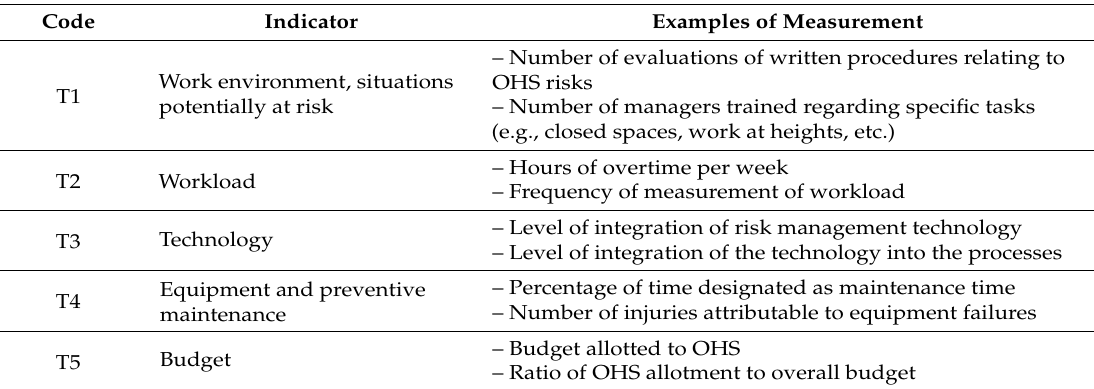
Table 5. Measurable indicators of risk management maturity based on tasks and resources-based indicators.